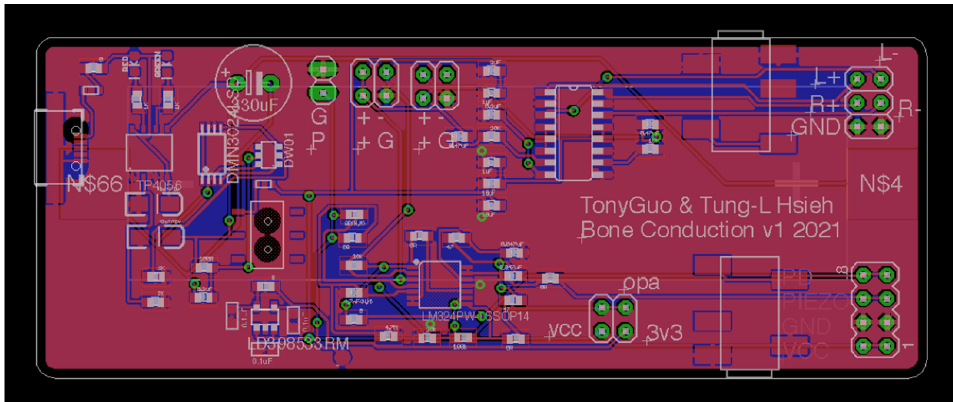
Figure 4. The PCB layout of the laser receiving device. The digital filtering algorithm running on the microprocessor processes the